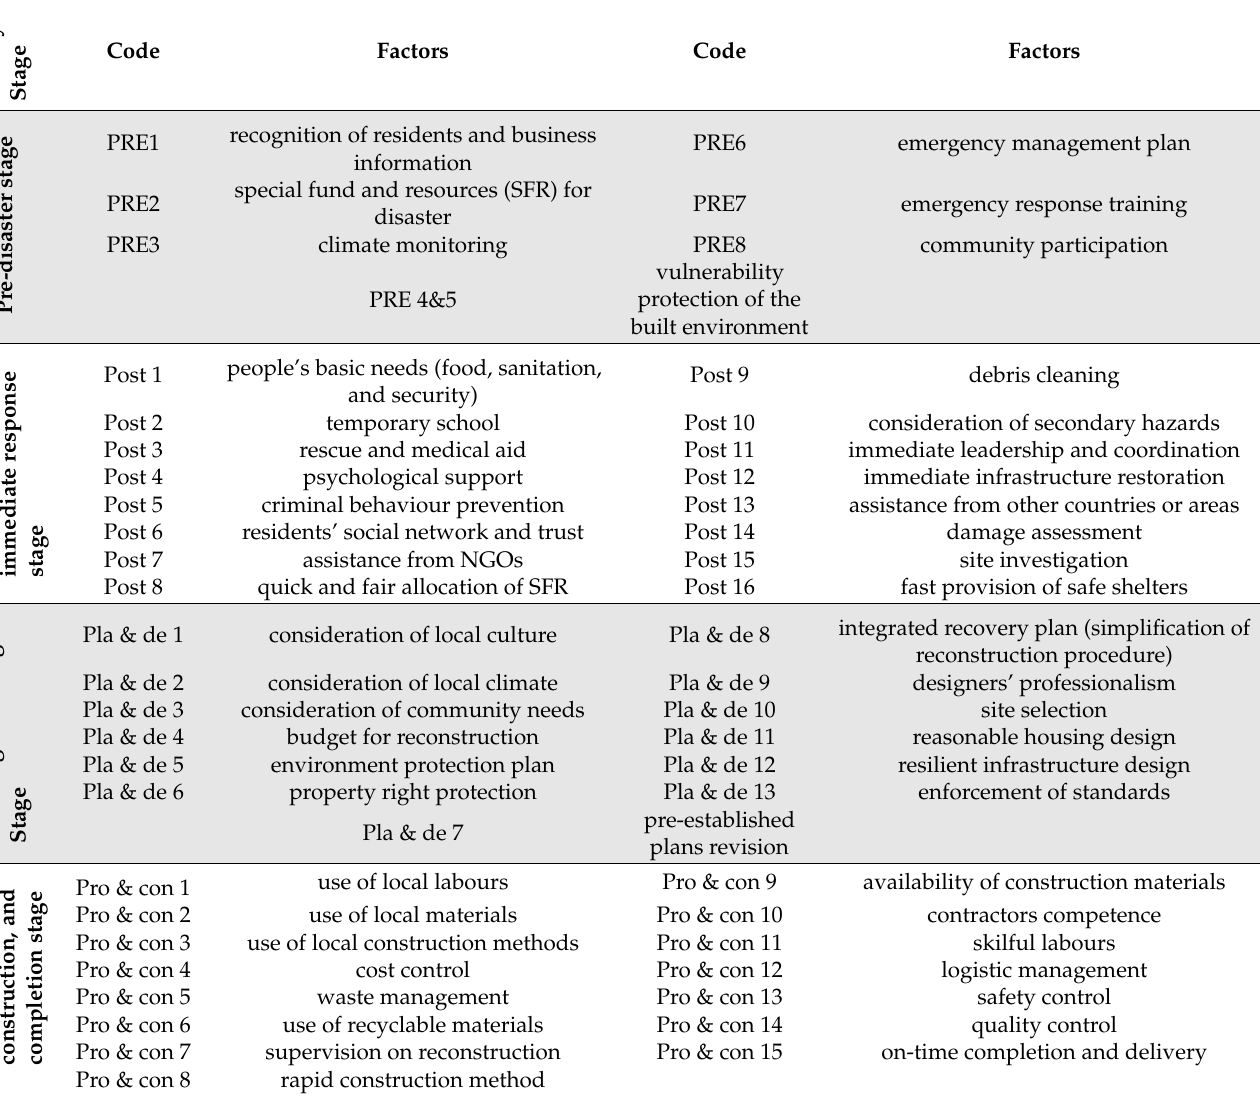
Table 2. Influential factors resulted from literature review and factors interrelationship analysis adapted/reprinted from ref.